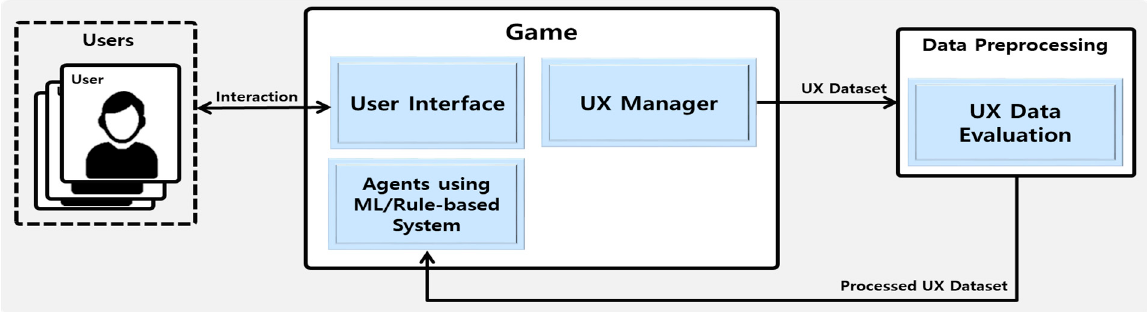
Figure 1. Traditional game agent system based on UX Framework.